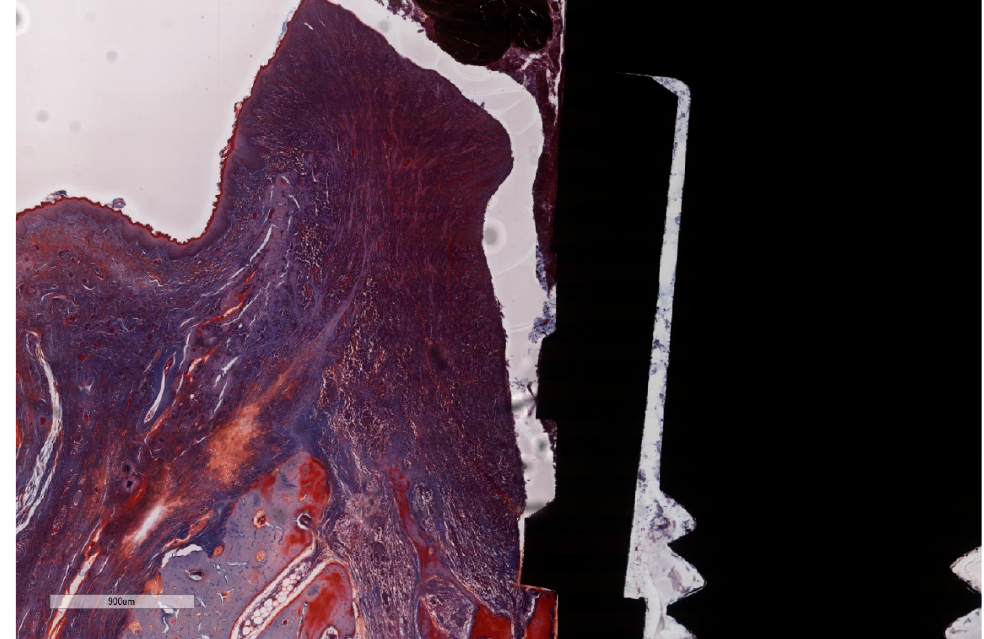
Figure 8. “Open wound” aspect of the ICT in contact with the implants surface and a total lack of the epithelial lining. ICT is diffusely present in the soft tissue and is seen to progress into the bone marrow, without any sign of fibrous encasement. The peri-implant sulcus is deep and the intimate contact between the soft tissues and the implant is below the BC level (implant #3, MGA, bar measure is 900 µm).